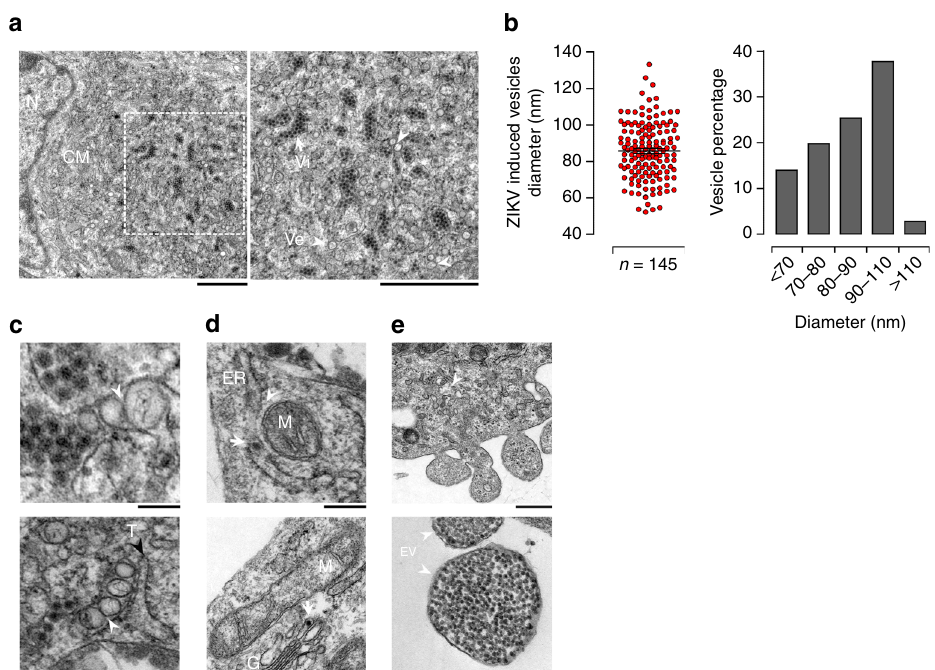
Fig. 7 Ultrastructure analysis of ZIKV induces membrane rearrangements in placental cells. a Representative TEM micrographs of 5 dpi ZIKV-infected placental cells. Convoluted membrane within ER lumen (CM) are localized next to the nucleus (N) shown in left panel. White rectangle denotes the enlarged region shown in right magni fi cation panel. Large number of single membrane cisterna containing aggregated virions (Vi) which closely associated with virus-induced vesicles (Ve) are shown the right magni fi cation panel. Arrowheads and arrows point to Ve and Vi, respectively. Scale bar, 1 μ m. b Diameter of ZIKV-induced vesicles is shown in the left panel. The size distribution of Ve is shown in the right panel ( n = 145) per ZIKV-infected placenta cells. Results are presented as mean values ± SEM. c Representative images of ZIKV-infected placental cells showing the localization of intracellular organelles depicted in ZIKV-infected cells ( a – f ). a , b Ve connected to each other through pores are indicated by white arrowheads. Scale bar, 100 nm. c , d Endoplasmic reticulum (ER) containing virions (Vi) are indicated by the white arrow, mitochondrion (M) and mitochondria-associated-membrane structures (white arrowhead) are shown, Golgi apparatus (G). e , f Representative micrographs showing viral budding from infected placenta cells and extracellular vesicles (EV) containing a large amount of viral particles are indicated with arrowheads. Scale bars, ( a – d ) 200 nm, ( e ) 500 nm, and ( f ) 200 nm. Data are representative of at least three independent experiments. Source data are provided as a Source Data fi